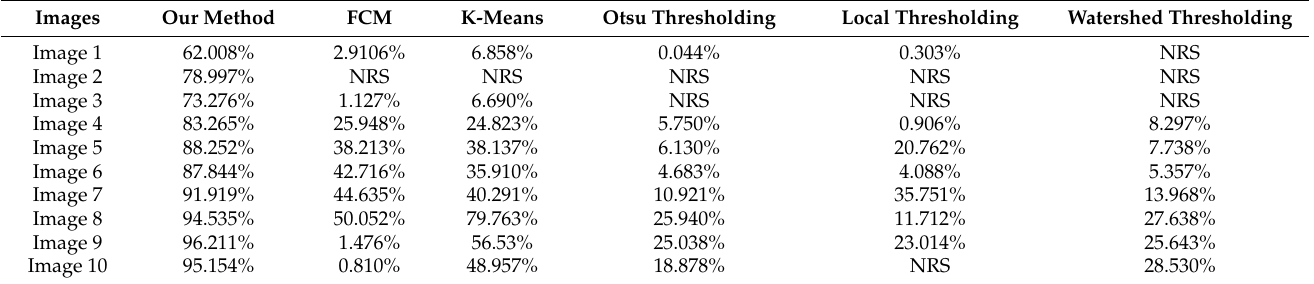
Table 5. Comparison between the results of our segmentation method on the KICA dataset and some well-known segmentation techniques using the Dice similarity coefficient.